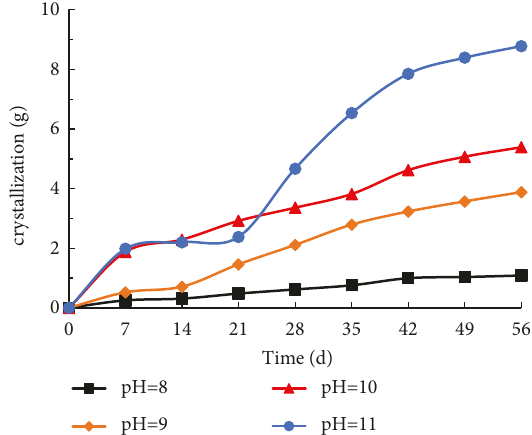
Figure 12: Crystallization amount of semi-filled test tube.